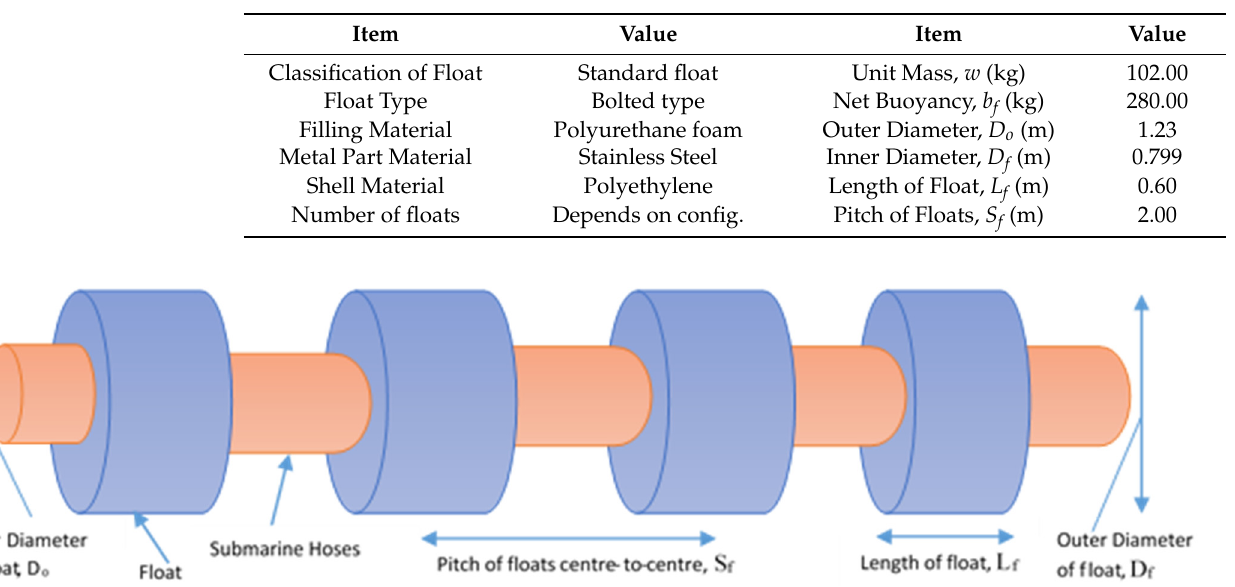
Figure 8. Typical floats attached to offshore submarine hoses .